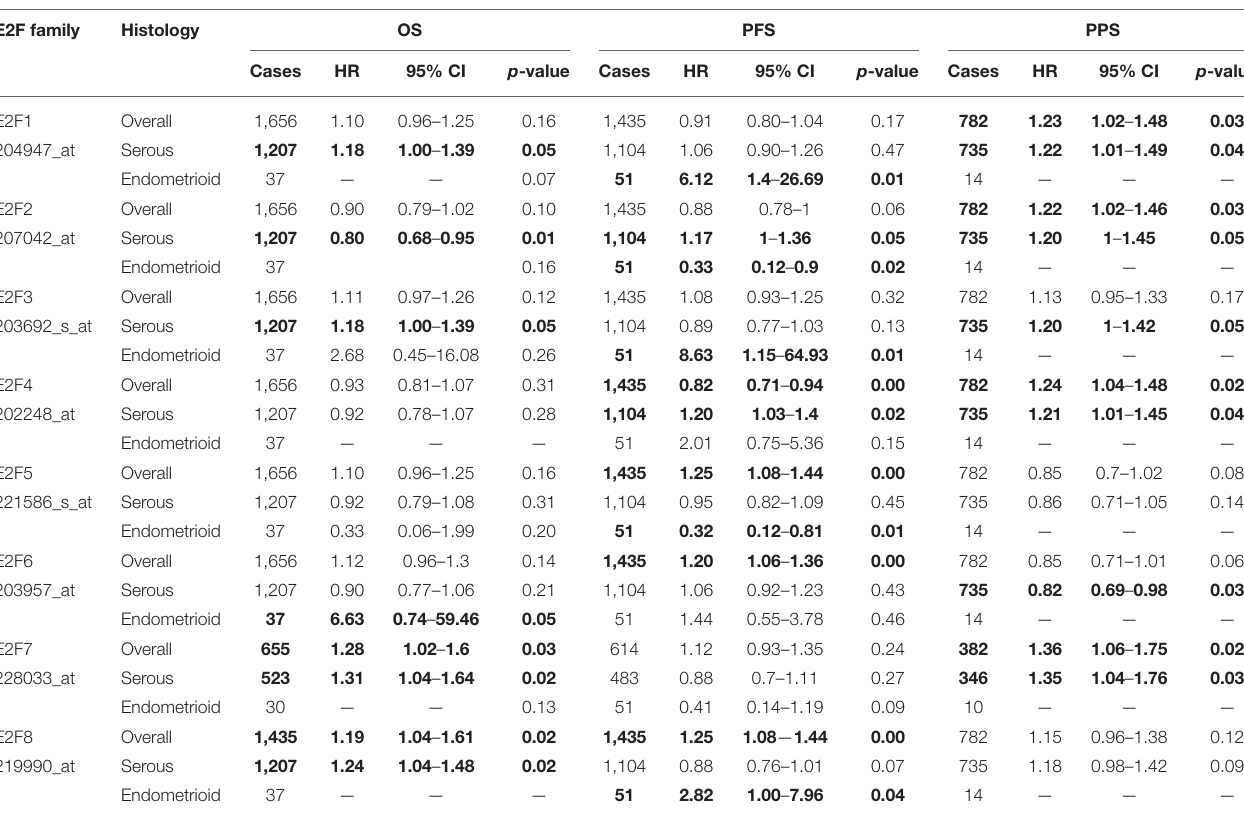
TABLE 4 | The Prognostic values of E2F family members in all and different pathological subtypes OC patients (Kaplan-Meier plotter).